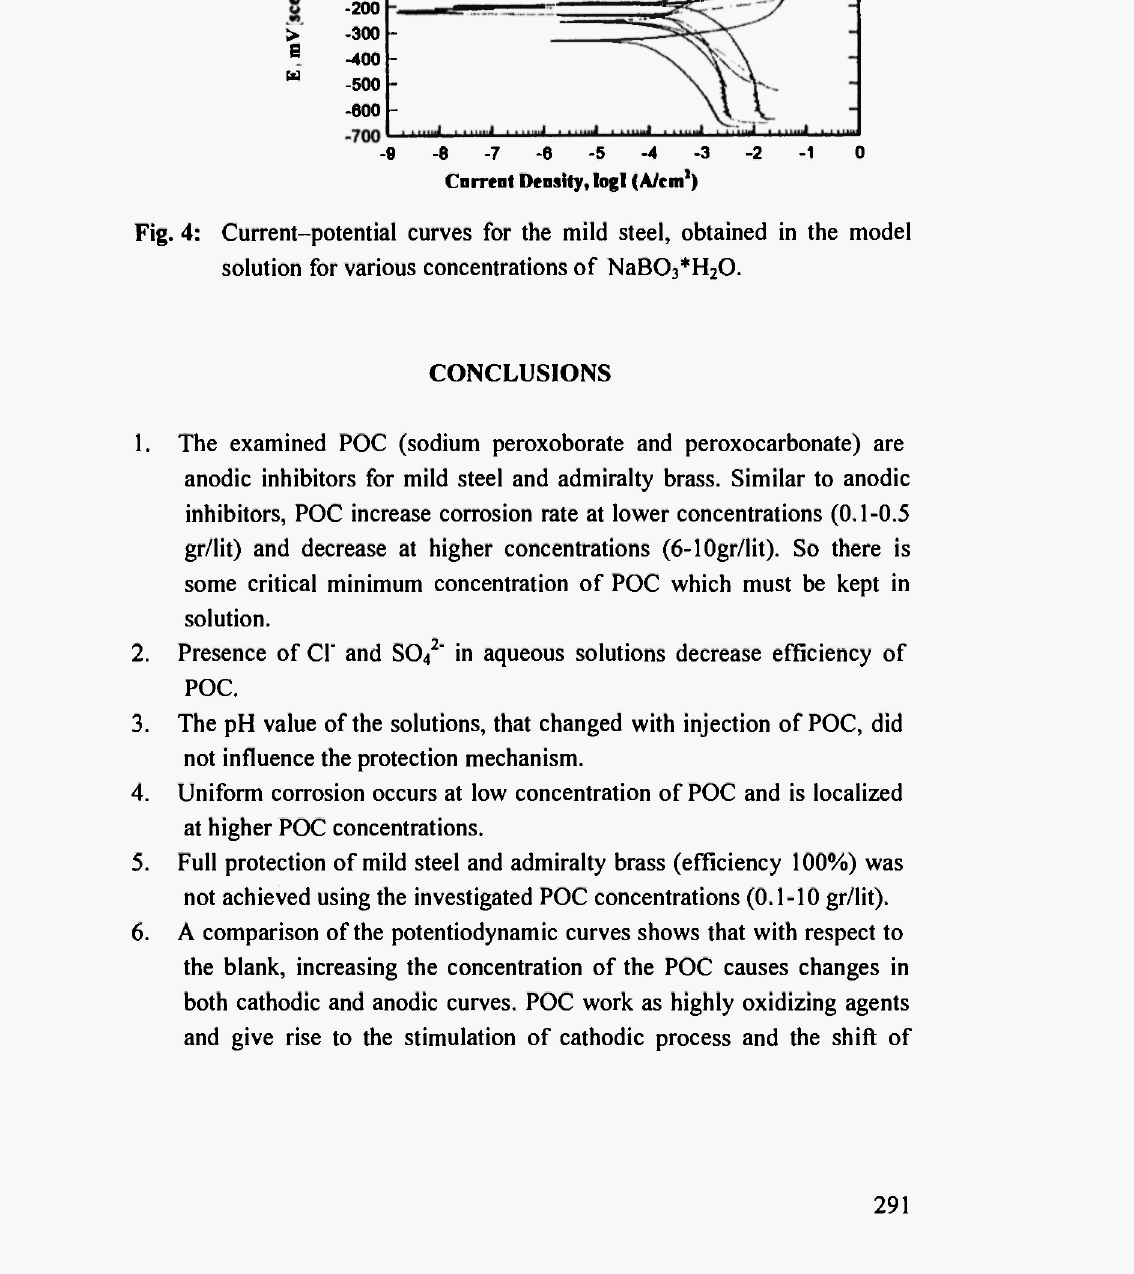
Fig. 4: Current-potential curves for the mild steel, obtained in the model solution for various concentrations of NaB0 3 *H 2